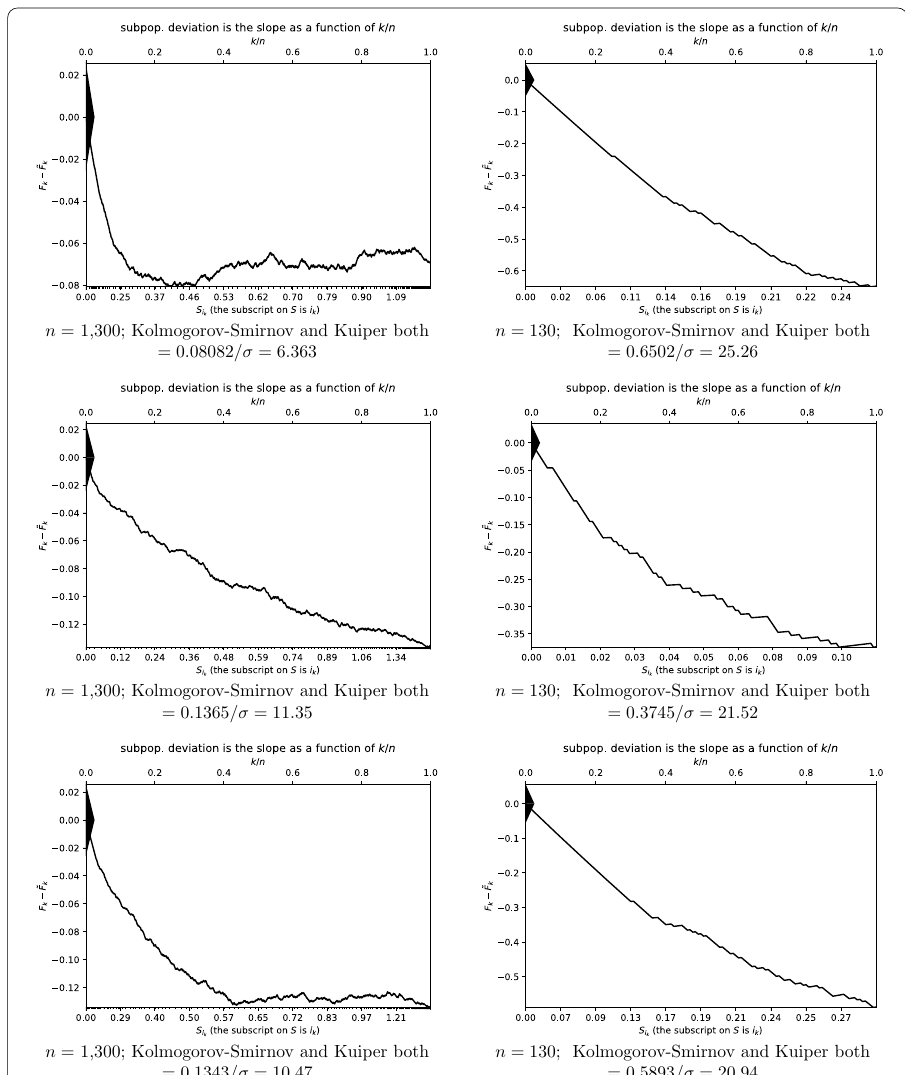
Fig. 20 Zooming in on the origin of some examples in which the scores are the negative log-likelihoods; the uppermost plots are for the Eskimo Dog or Husky of Fig. 9, the middlemost plots are for the night snake (Hypsiglena torquata) of Fig. 11, and the lowermost plots are for the sidewinder/horned rattlesnake (Crotalus cerastes) of Fig. 18; each plot on the right zooms in on the origin of the plot to its left, adjusting the height of the triangle at the origin, the number n of observations, and the Kuiper and Kolmogorov-Smirnov statistics to reflect the smaller range of scores on the horizontal